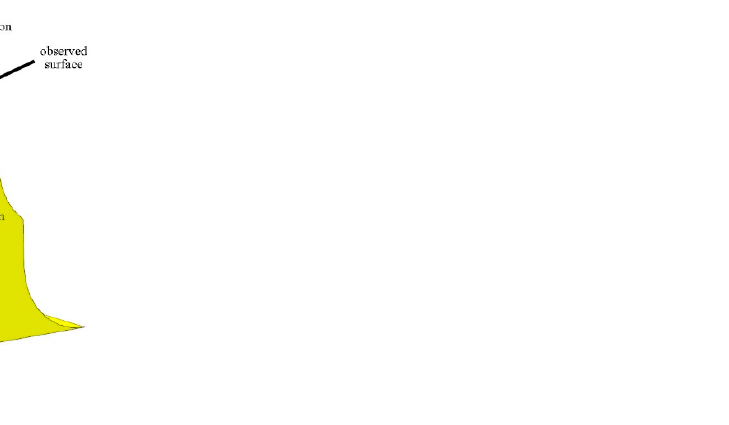
Figure 9. The macroscopic morphology of the seal fin. ( a ) The original seal fin; ( b ) the seal fin with only radial rub; ( c , e , g , i ) the axial rub sides of the seal fins at 60, 80, 100, and 120 μ m/s respectively; ( d , f , h , j ) the non-axial rub sides of the seal fins at 60, 80, 100, and 120 μ m/s respectively; ( k ) the observed surface.